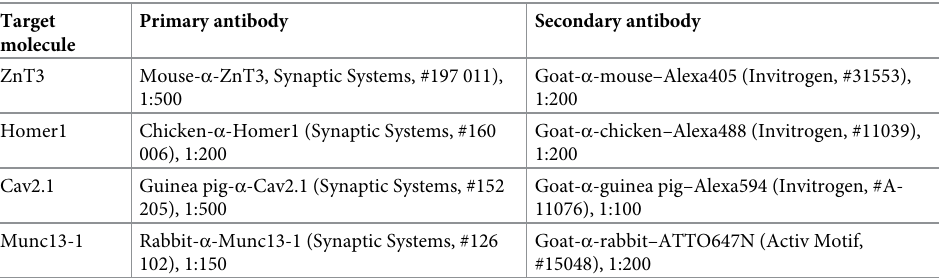
Table 2. Antibodies used in immunohistological staining AU : IhaveaddedatitleandacalloutforTable 2 : Pleasecheckthatthesearesuitable : Ifnot ; pleaseedit :